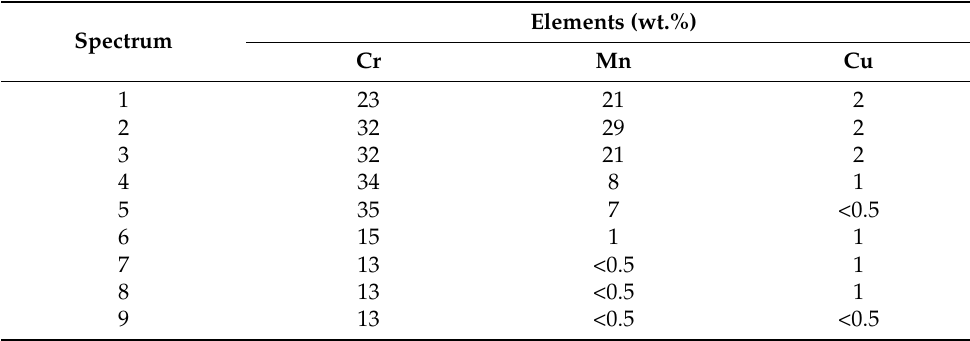
Table 6. Results of EDS analysis performed at spots of Figure